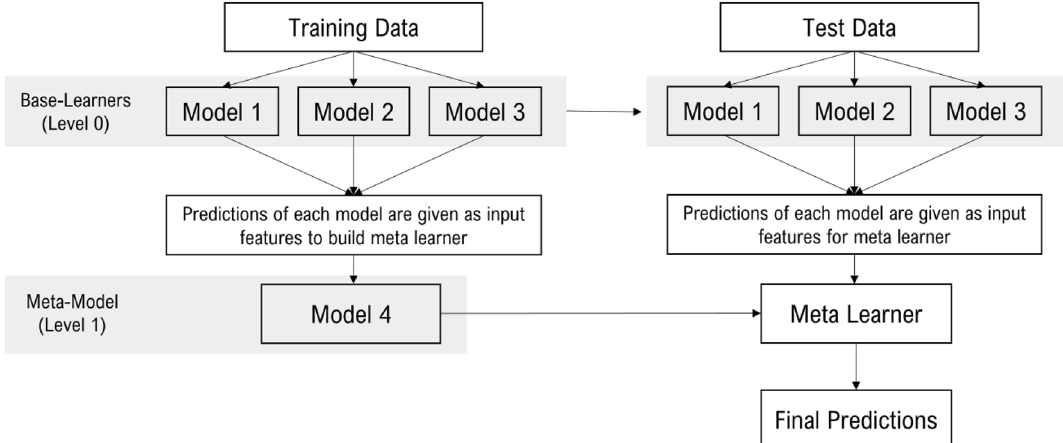
Figure 1. Illustration of StackBox framework. The framework builds distinct base learners (using the training data), and from these models predicts the bounding boxes around the detected objects. Using these predictions as input and using the ground-truth as output, a meta-model combines the base learners’ output, building a new model with improved performance. The base learners built previously are subsequently applied to the test data set to detect polyps on unseen data. Finally, these detections are used as input features for the meta-learner built on the training data to obtain the final predictions on the test data